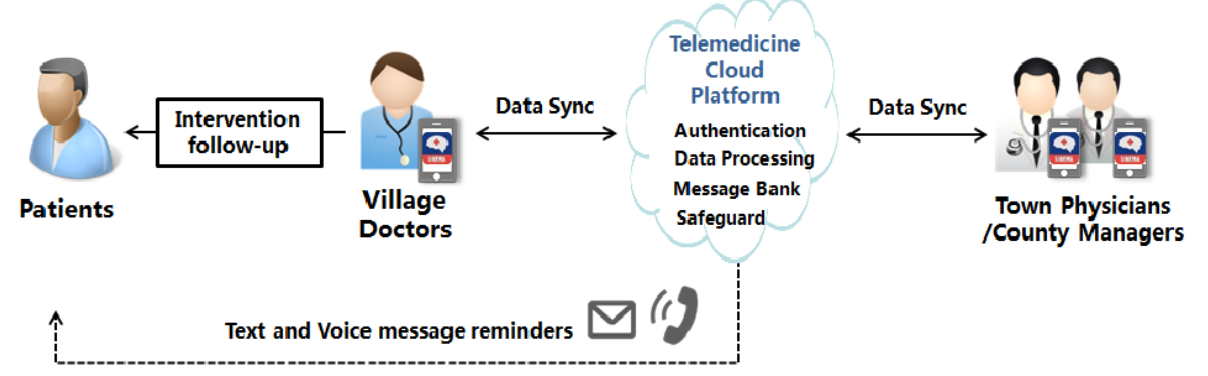
Figure 2. A schematic diagram of the system-integrated technology-enabled model of care mobile health